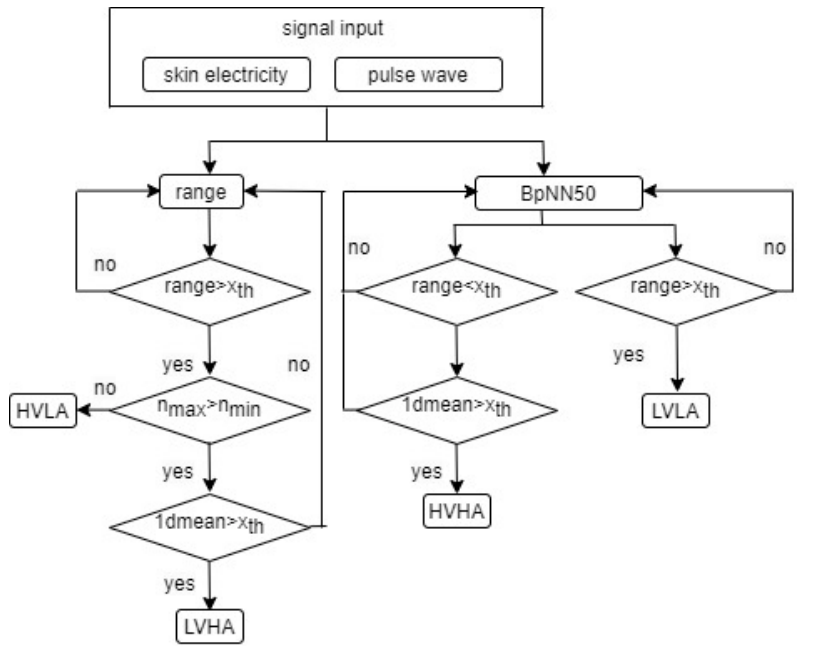
Figure 2. Model of emotion